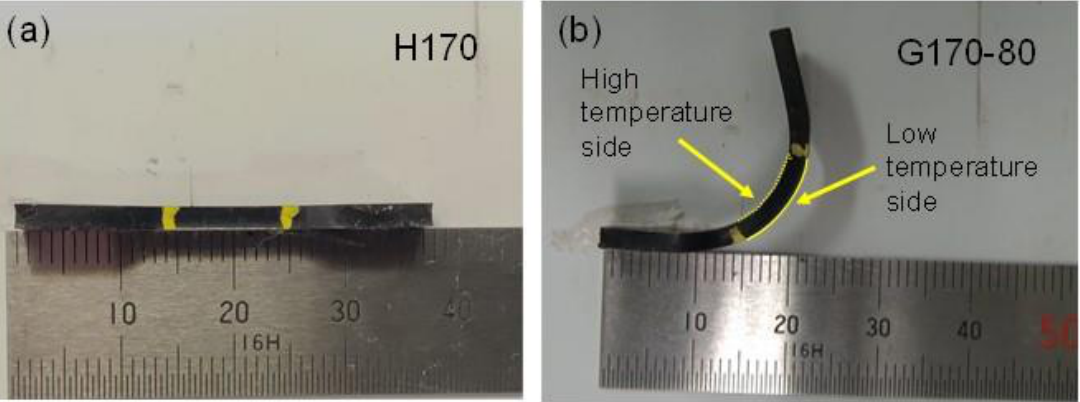
Figure 5. Sample shapes immediately after removal from the tensile machine for ( a ) H170 and ( b ) G170-80. The pictures were taken from a side view of the samples.